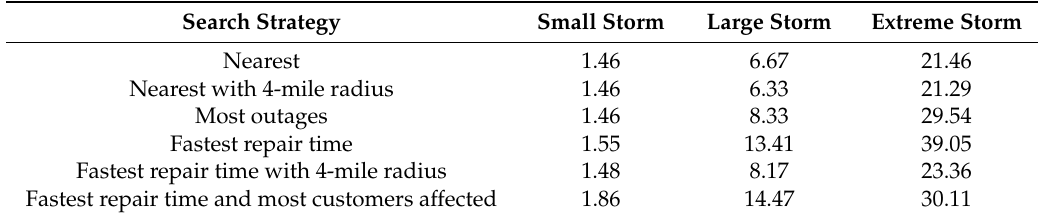
Figure 8. Search strategy for simulated storms. Crew start location set to area work center and search strategy as indicated. Travel speed set to 25 mph, 272 crews with 85% working during day shift, 99% working during evening shift and 66% working during night shift, 1 to 10 h repair time range. 1000 outages for small storm, 5000 outages for large storm, 15,000 outages for extreme storm. Nearest within 4-mile radius led to faster restoration times. Table 5. Time to system restoration (in days) based on search strategy from Figure